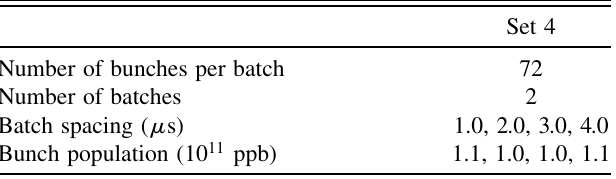
TABLE II. Parameters used in the simulations for the mea- surements with 25 ns bunch spacing.